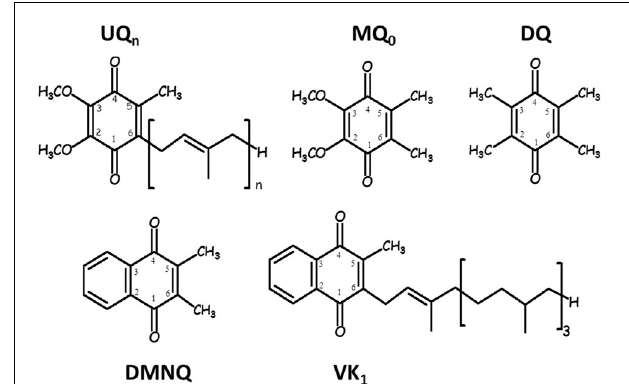
FIGURE 1 | Structure and numbering of ubiquinone (2,3-dimethoxy, 5-methyl,6-prenyl benzoquinone) (UQ n ), 2,3-dimethoxy, 5,6-methyl benzoquinone (MQ 0 ), 2,3,5,6-methyl benzoquinone (duroquinone, DQ), 2,3-dimethyl, 1,4-naphthoquinone (DMNQ) and 2-methyl, 3-phytyl 1,4-naphthoquinone (VK). The numbering scheme employed here for the naphthoquinonestructures is nonstandard, and was chosen to facilitate comparison between naphthoquinoneand ubiquinone